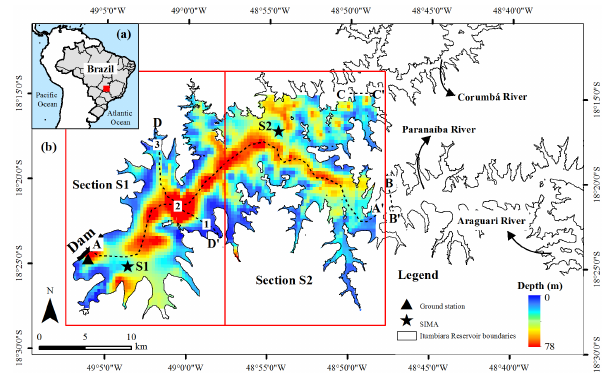
Figure 1. Location of the Itumbiara Reservoir in central Brazil (a) and its detailed boundaries and bathymetry (b)